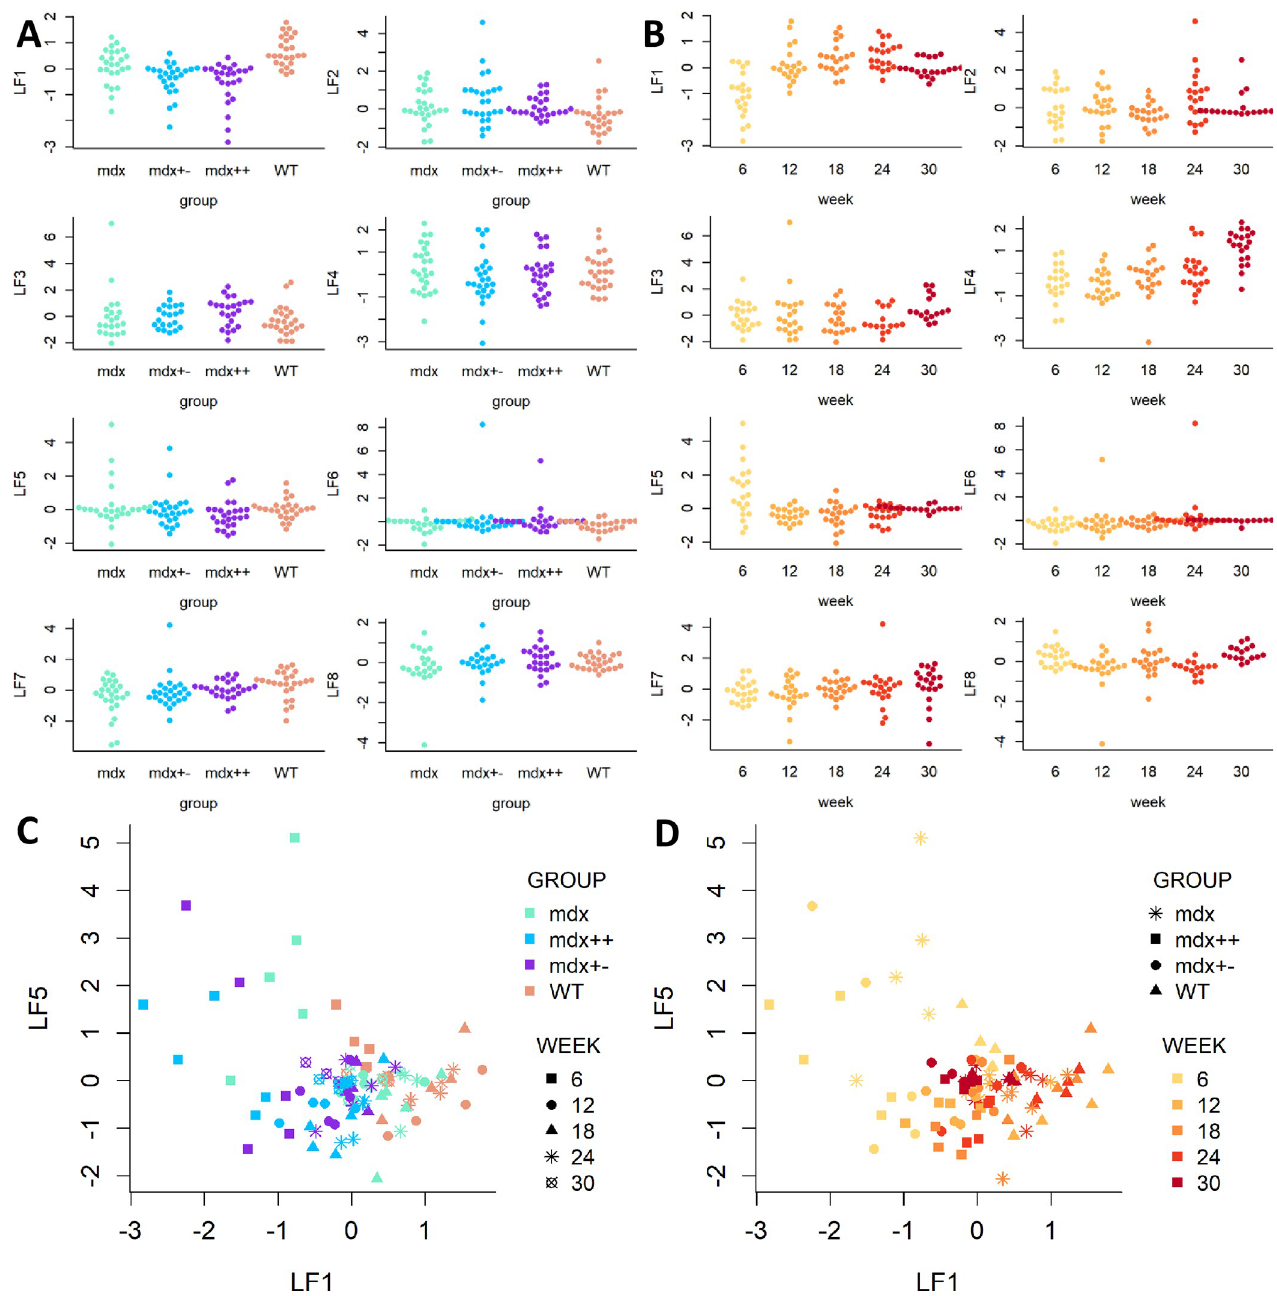
Fig 3. Latent space representation of the 8 MOFA factors. A) Beeswarm plots representing the distribution of each latent factor across the 4 mouse groups. B) Beeswarm plots representing the distribution of each latent factor by week. C) Latent space representations of factors 1 and 5. The colour of dots denotes mouse group, and the shape denotes the week of sampling. D) Latent space representations of factors 1 and 5. The colour of dots denotes week of sampling, and the shape denotes mouse group. dystrophic mice (WT vs the 3 dystrophic groups) and differences in genetic background (WT and mdx vs mdx++ and mdx+- mice). Moreover, LF1 also separates samples gathered at week 6 from samples obtained at later time points (Fig 3B); this separation is interesting, as week 6 typically represents the phase of intense skeletal muscle damage and repair, which is followed